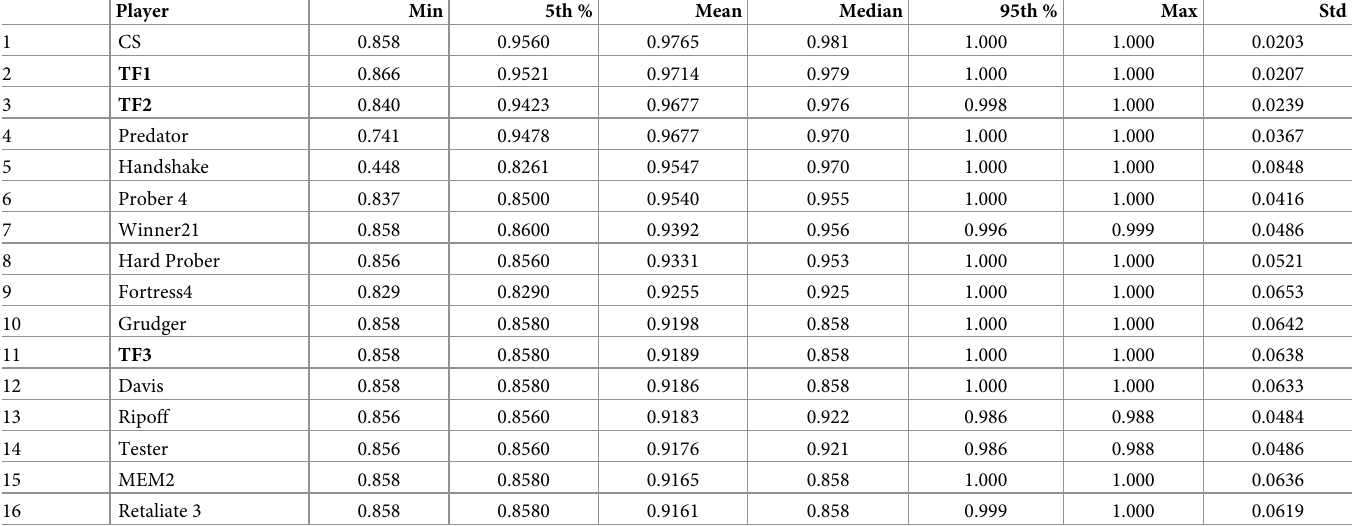
Table 9. Top resistors for N =